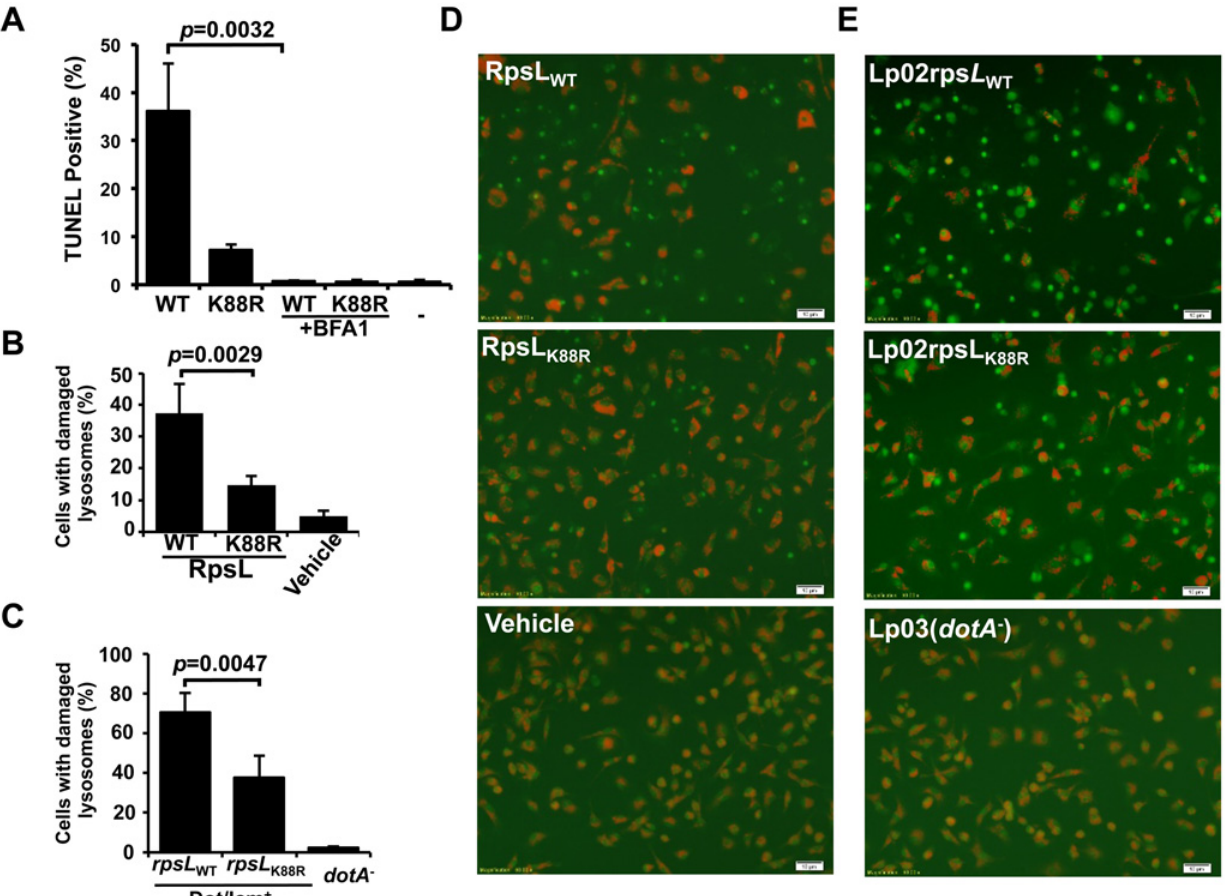
Fig 5. RpsL caused lysosome membrane permeabilization. A . Vacuole acidification is important for RpsL-induced macrophage death. Recombinant RpsL was transfected into BMDMs from A/J mice, bafilomycin A1 (20 nM), the inhibitor for vacuolar ATPase was added to a subset of samples. Cells fixed at 6 hrs after transfection were subjected for TUNEL staining. TUNEL signals were inspected and scored under a fluorescence microscope; at least 500 cells were examined in each sample performed in triplicate. B . RpsL caused lysosomal membrane damage. Purified RpsL or RpsL K88R was delivered into BMDMs; after incubation in 5% CO 2 at 37°C for 8 hrs, samples were centrifuged at 200 g for 5 min, the culture medium was replaced with 0.5 ml of AO solution (5 μ g/ml in PBS). The plate was incubated in 37°C for 15 min before imaging with a fluorescence microscope. Data shown are the percentage of cells with damaged lysosome (loss of red florescence) from one representative from three experiments with similar results. Quantitative results were obtained from at least 500 cells. C . Infection by L . pneumophila strain harboring wild type RpsL caused lysosomal membrane damage. BMDMs from A/J mice were challenged with indicated strains at an MOI of 1. Extracellular bacteria were removed with extensive wash 1 hr post infection, and cells were then stained with AO 7 hrs postinfection. The percentage of cells with ruptured lysosomes was quantitated from at 500 cells. All samples were performed in triplicate and similar results were obtained in at least 3 independent experiments. D-E . Representative images of AO fluorescence emission of BMDMs transfected with RpsL ( D ) or infected with relevant L. pneumophila strains ( E ).-, transfection reagent only. Bar, 10 μ m.